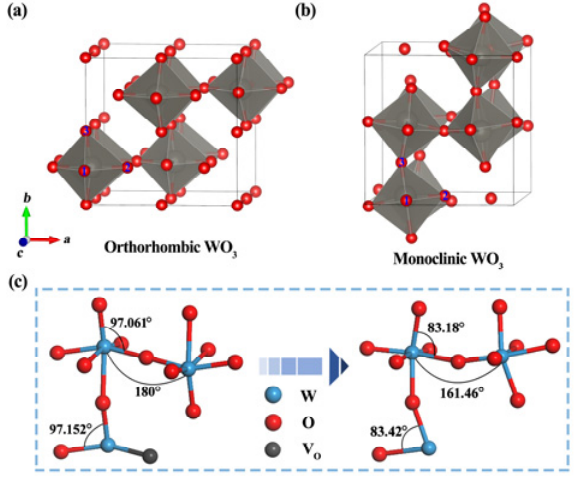
Fig. 3 Crystal structure models of (a) orthorhombic and (b) monoclinic phases. Grey ball are the W atoms, and red balls are O atoms. Among these, 1, 2, and 3 are the different positions of oxygen atoms. (c) Oxygen vacancy-induced transition mechanism from orthorhombic to